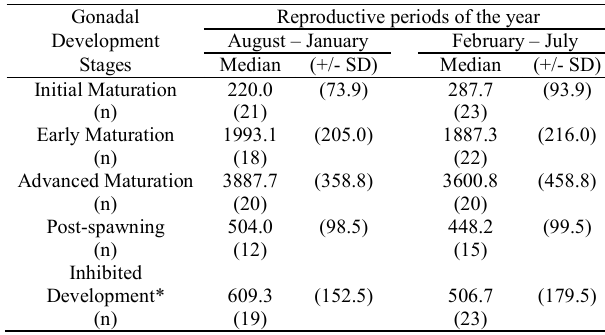
Table 4. Mean concentration (pg/ml) and standard deviation (+/- SD) of total testosterone in non-infested females of Cy- phocharax gilbert in different gonadal development stages and infested females (*) from rio Itabapoana, Brazil, from